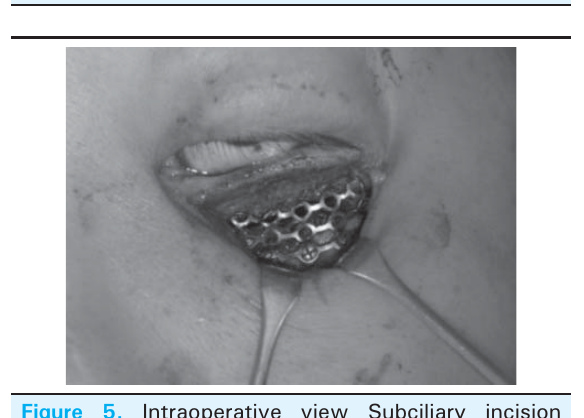
Figure 5. Intraoperative view Subciliary incision allowed titanium mesh reconstruction